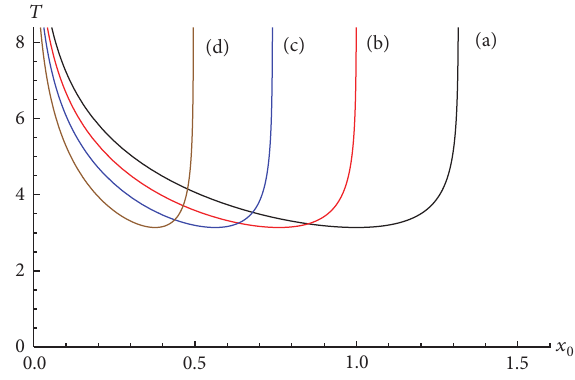
Figure 6: Exact period T in (49) as a function of the initial amplitude 𝑥 0 when 𝑎 1 = −1 , 0 < 𝑥 0 < (−3𝑎 1 /𝑎 5 ) 1/4 and (a) 𝑎 5 = 1 , (b) 𝑎 5 = 3 , (c) 𝑎 5 = 10 , and (d) 𝑎 5 = 50 .